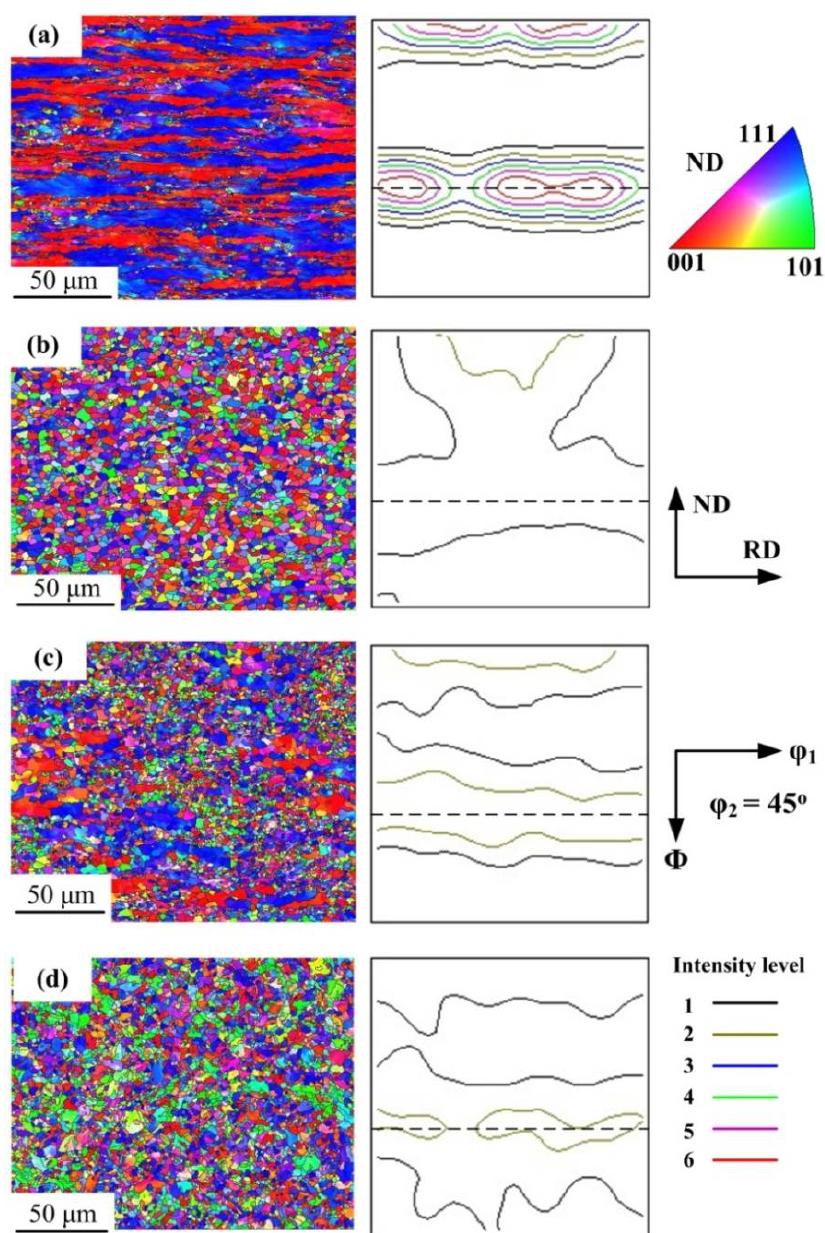
Figure 12. Grain orientation map of ( a ) 750 °C, 1 s −1 ( b ) 800 °C, 1 s −1 ( c ) 800 °C, 10 s −1 ( d ) 850 °C, 10 s −1 .